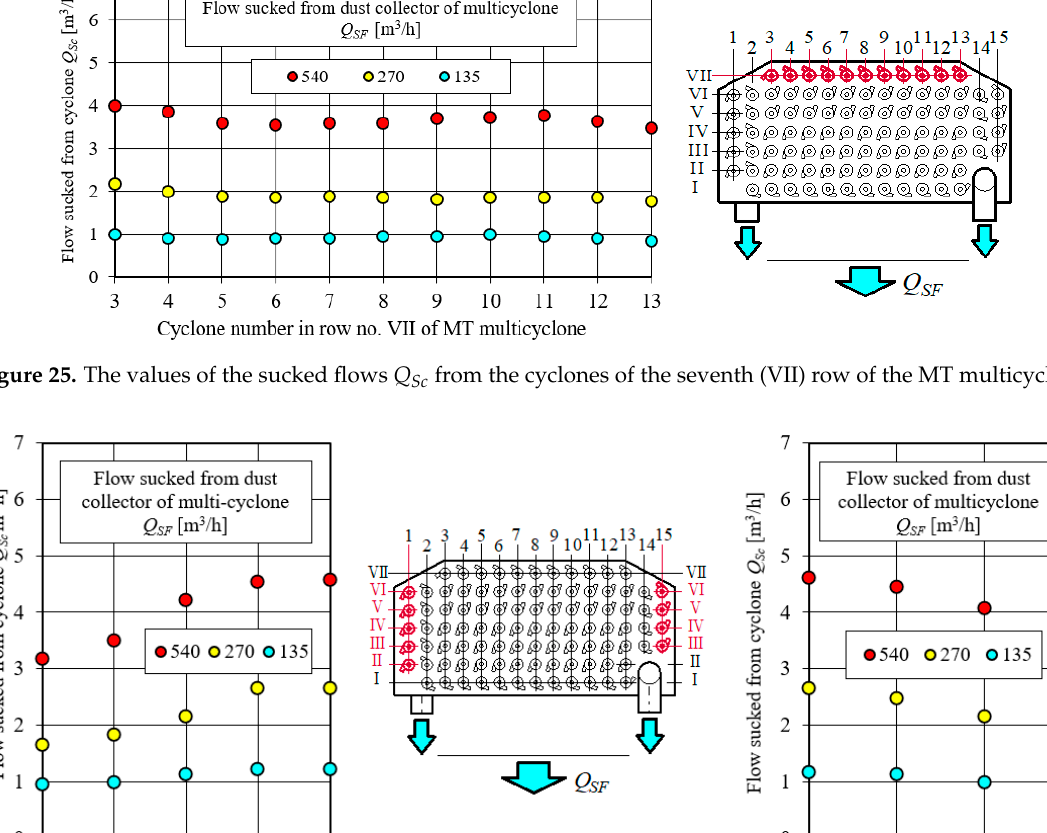
Figure 25. The values of the sucked flows Q Sc from the cyclones of the seventh (VII) row of the MT multicyclone.